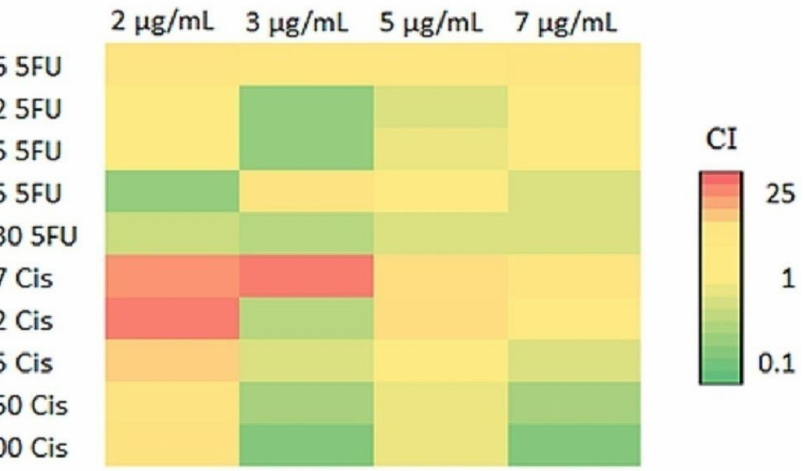
Figure 8. Heatmap for predicted drug combination effects of PPE with 5FU and cisplatin. The predicted CI values from the most synergistic to the most antagonistic pair arecolored from green to